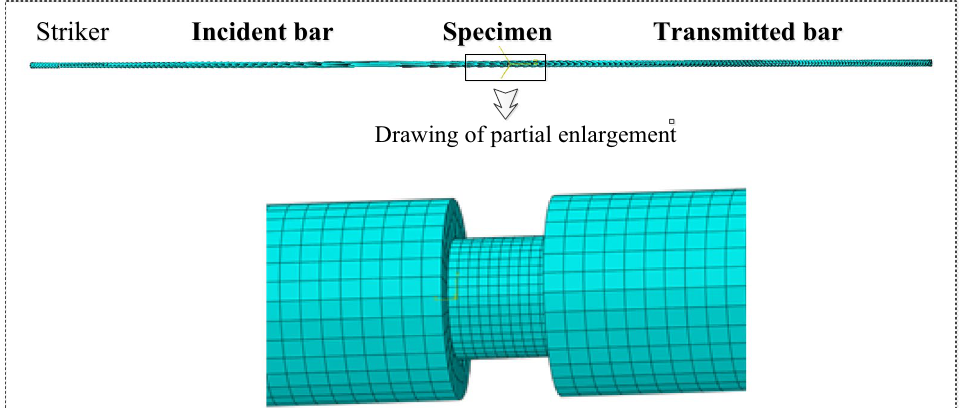
Figure 4. Finite element